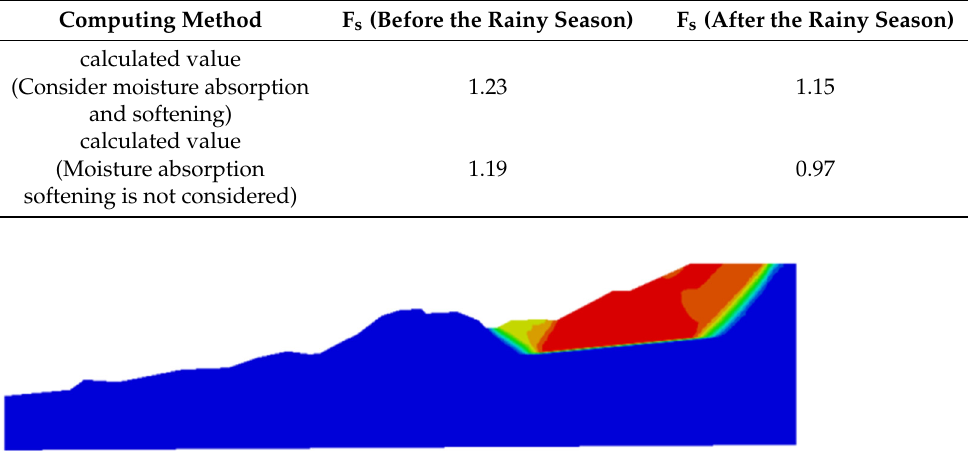
Figure 11. Potential sliding surface of slope (Fs = 0.97).